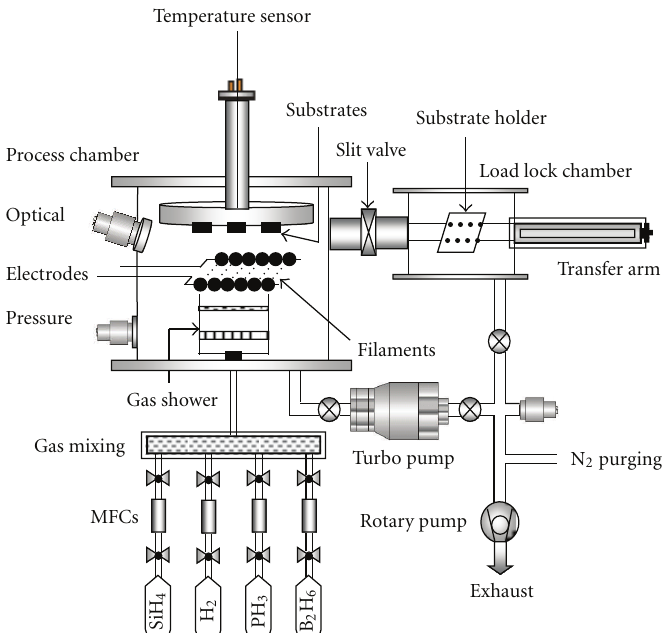
Figure 1: Schematic of indigenously designed, developed, and commissioned dual chamber hot wire method for the synthesis of Si:H thin